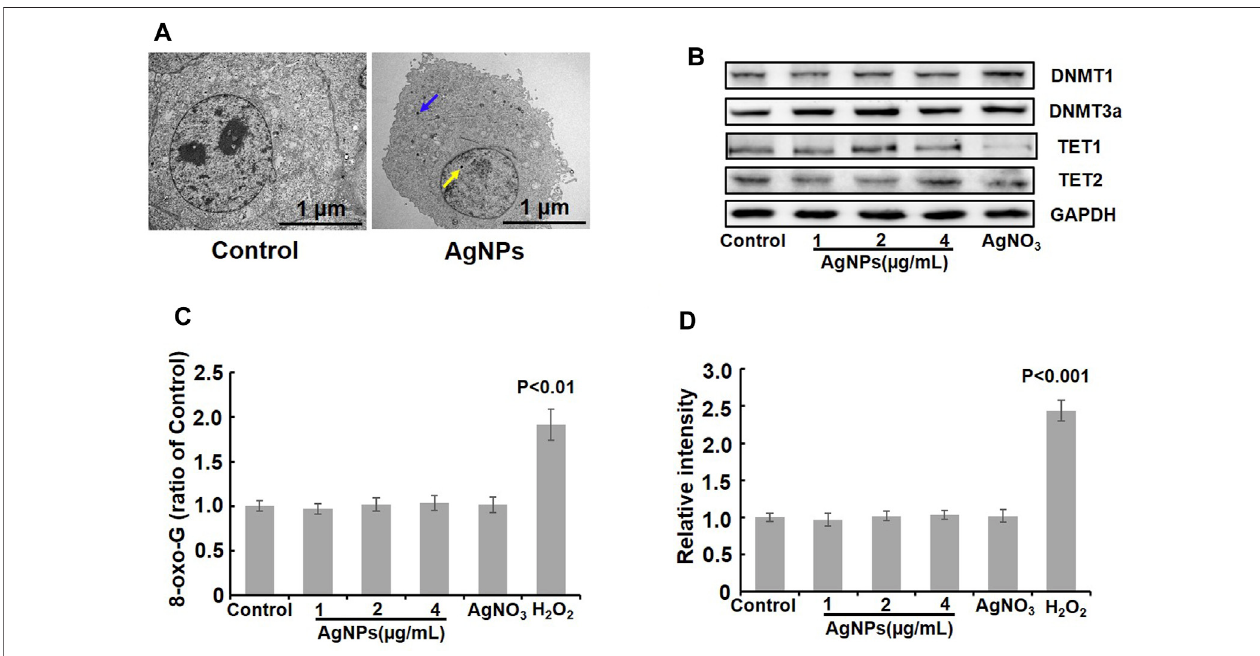
FIGURE6| LocalizationofAgNPs,levelsofmethylationrelatedenzymes,DNAdamageandROSdetectionafterAgNPstreatment. (A) RepresentativeTEMimages showing intracellular localization of AgNPs after exposure with 4 μ g/ml AgNPs for 24 h. Original magni fi cation ×10,000. (B) Western blot analysis of DNMT1, DNMT3a, TET1,and TET2 inHEK293T cellstreated withAgNPsand Agionsfor24 h. (C) Relative 8-oxo-G levelwasdetectedinHEK293T cellsuponAgNPs and Agions for24 h ( n = 4). (D) Relative total ROS level was examined in HEK293T cells exposed to AgNPs and Ag ions for 24 h ( n = 4).